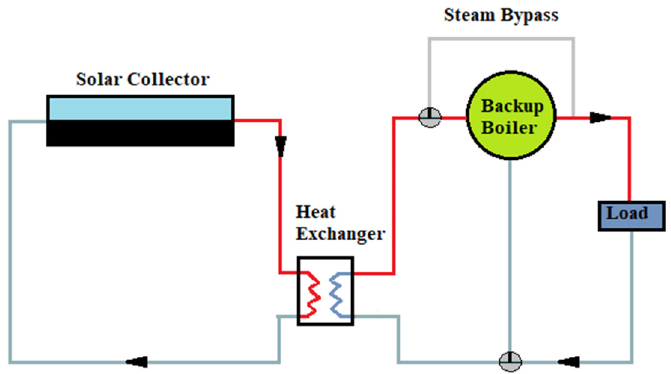
Figure 8. Indirect steam generation system with flash boiler with backup. Adapted from Ref. [44], Copyright (1985), with permission from Elsevier.